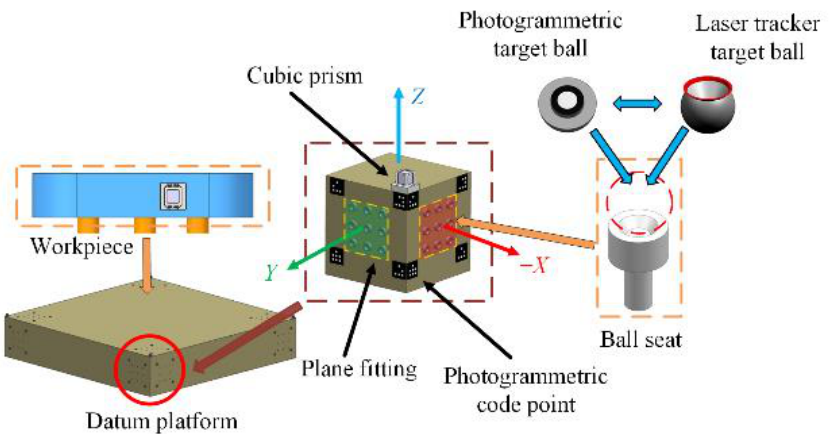
Figure 5. Datum alignment of the laser tracker and photogrammetry system.